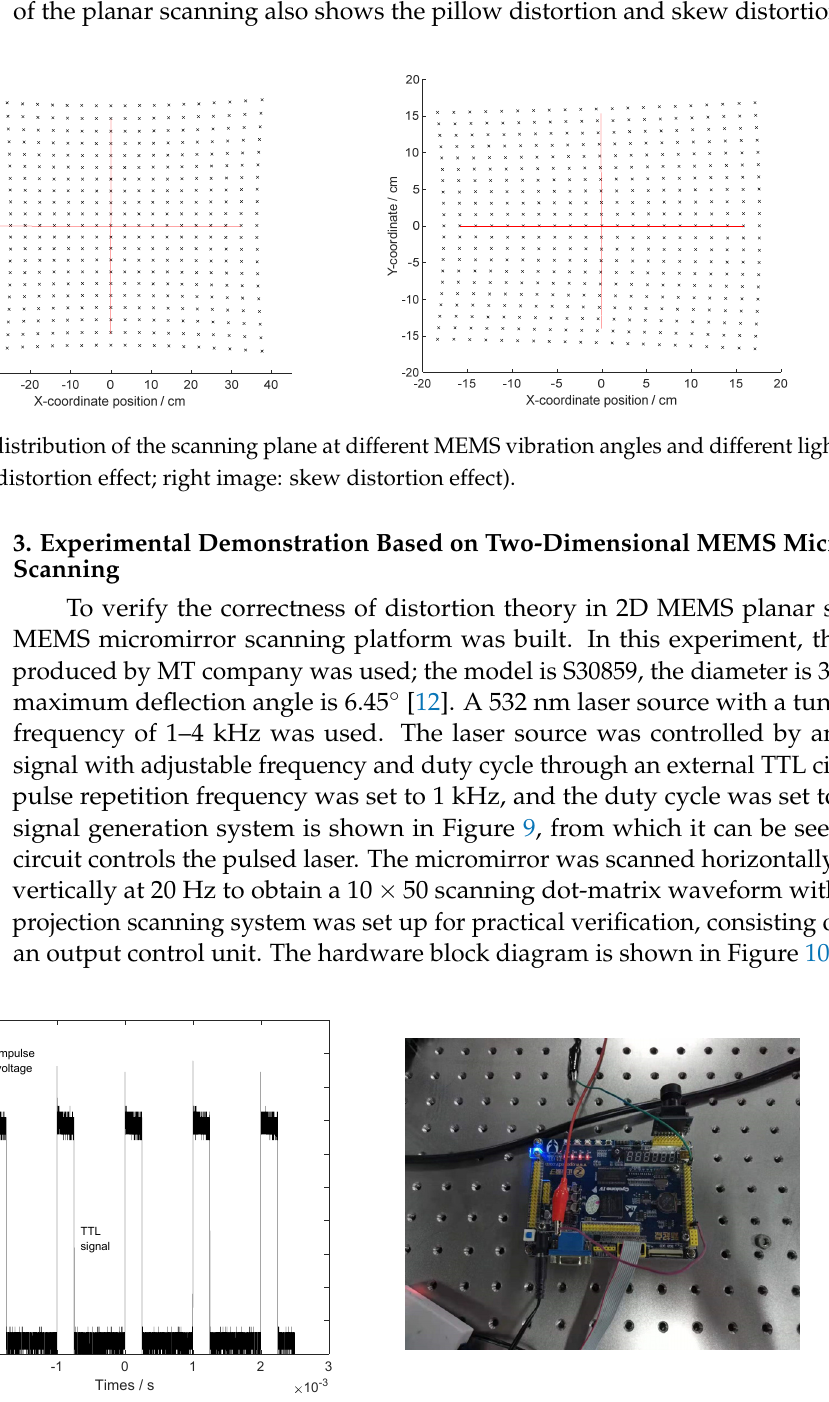
Figure 9. TTL signal generation system (left figure: TTL signal + laser impulse; right figure: TTL